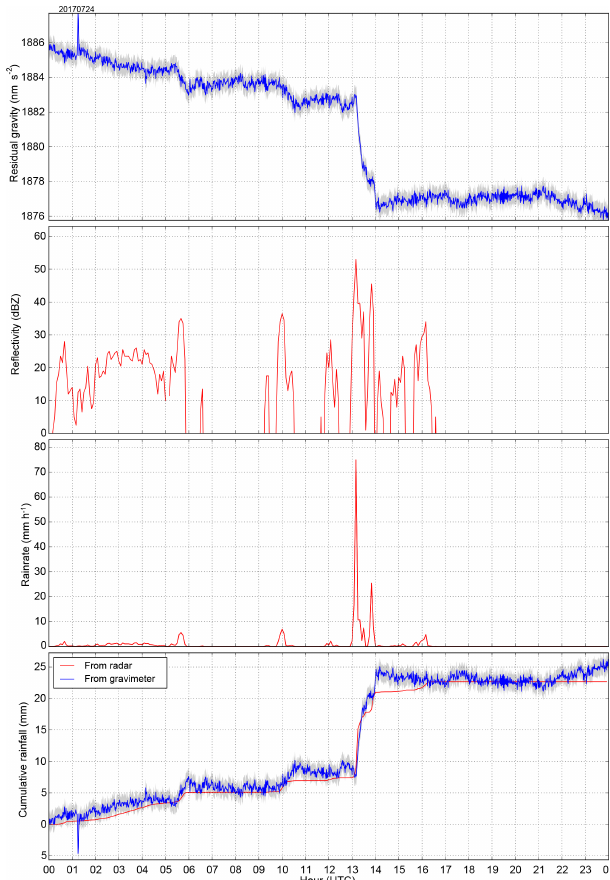
Figure 2. Time series for 24 July 2017 00:00–24:00UTC: residual gravity (nms − 2 ), radar reflectivity (dBZ), radar-derived rainfall rate (mmh − 1 ) and cumulative rainfall (mm) derived from gravity and radar.